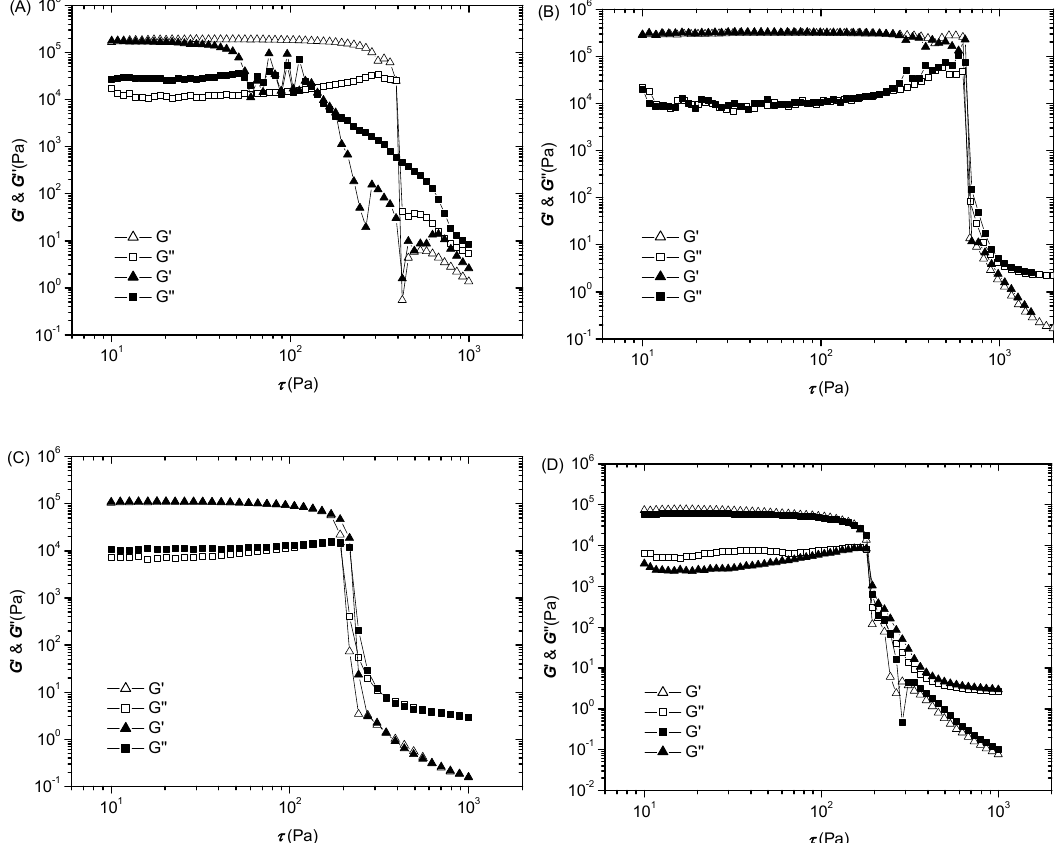
Figure 8. Storage modulus and loss modulus as a function of stress of the suspensions at 2.0 kV/mm electric field: ( A ) P[VBTMA][PF 6 ]; ( B ) P[VBTMA][PF 6 ]-c-PANI; ( C ) P[VBTMA][PF 6 ]/PANI mixture; ( D ) PANI. Solid points were obtained when the rotation side of the electrode was anode, and open points were obtained when the rotation side of the electrode was cathode ( φ = 27 vol %, T = 23 °C).